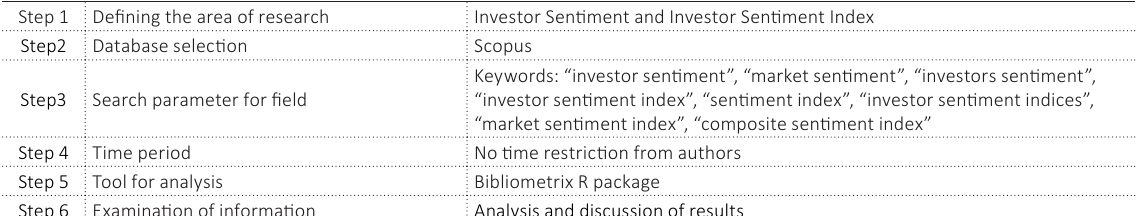
Table 1. Characteristics of the bibliometric study